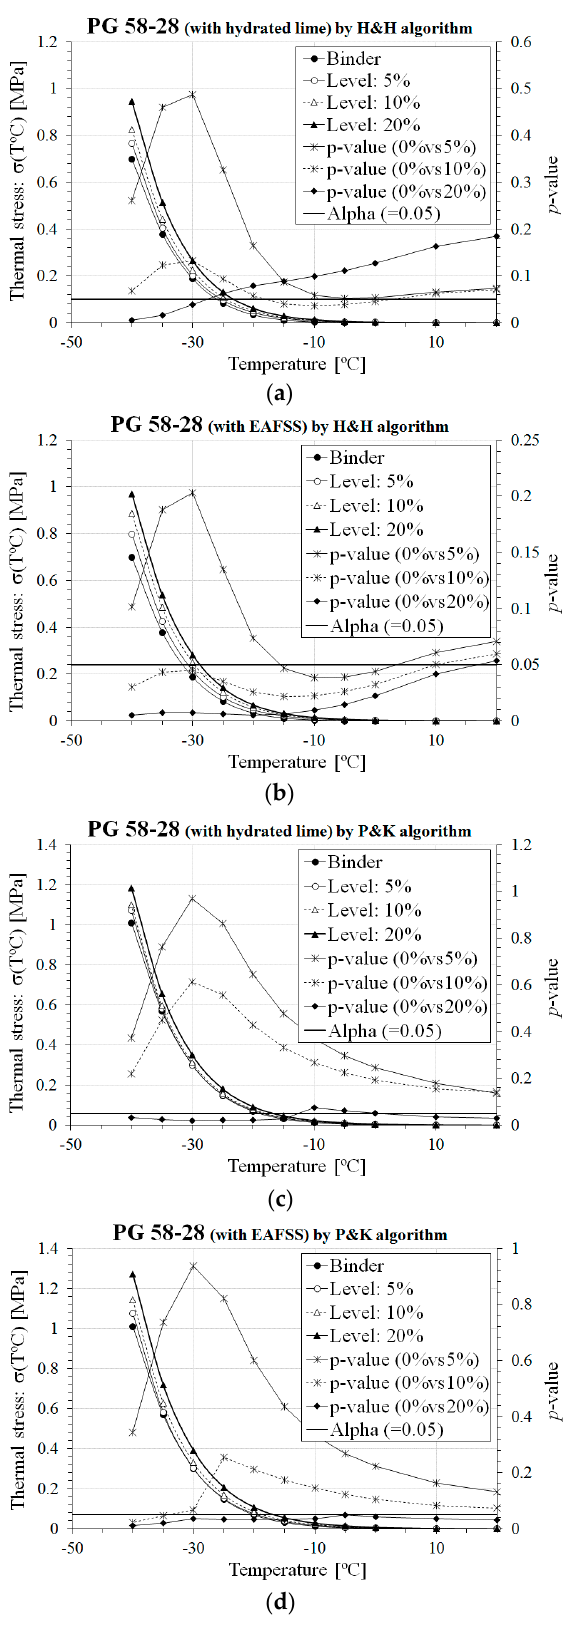
Figure 4. Comparison of σ ( T ) and T CR for PG 58-28 binder. ( a ) PG 58-28 (with hydrated lime) by H&H algorithm; ( b ) PG 58-28 (with EAFSS) by H&H algorithm; ( c ) PG 58-28 (with hydrated lime) by P&K algorithm; ( d ) PG 58-28 (with EAFSS) by P&K algorithm.